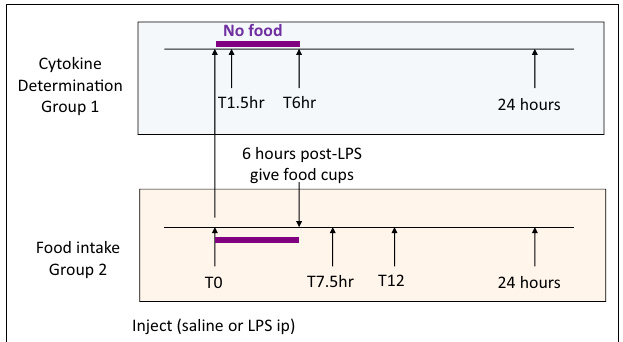
FIGURE 1 | Time lines for cytokine (group 1) and food intake (group 2) measurements